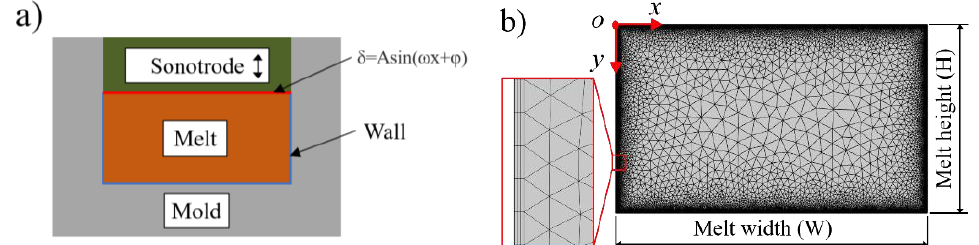
Figure 1. Numerical model: ( a ) boundary conditions; ( b ) finite element mesh.